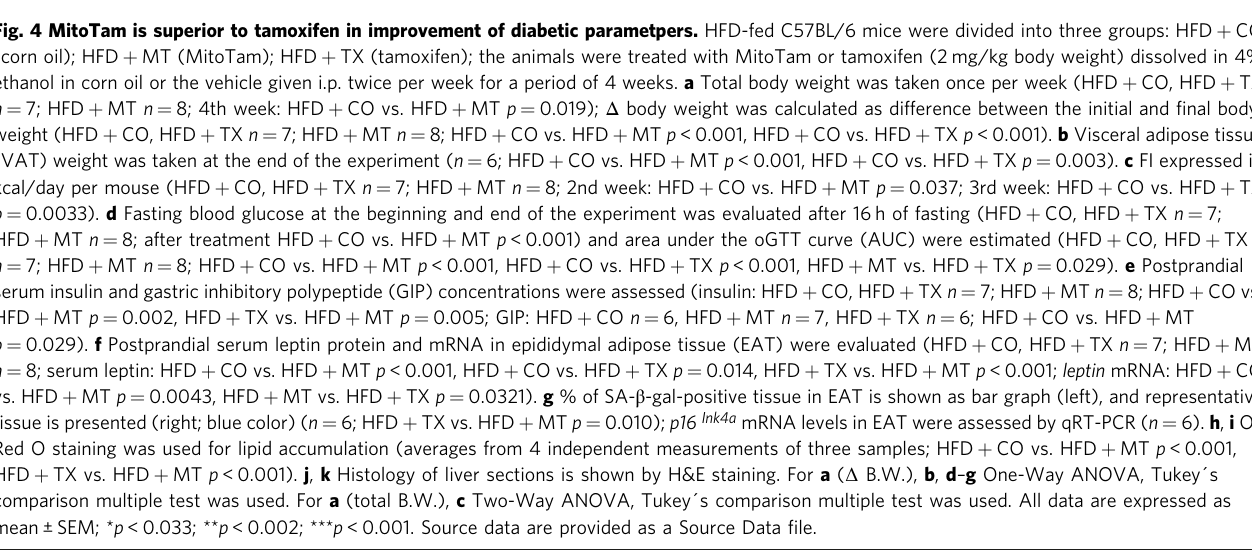
Fig. 4 MitoTam is superior to tamoxifen in improvement of diabetic parametpers. HFD-fed C57BL/6 mice were divided into three groups: HFD +